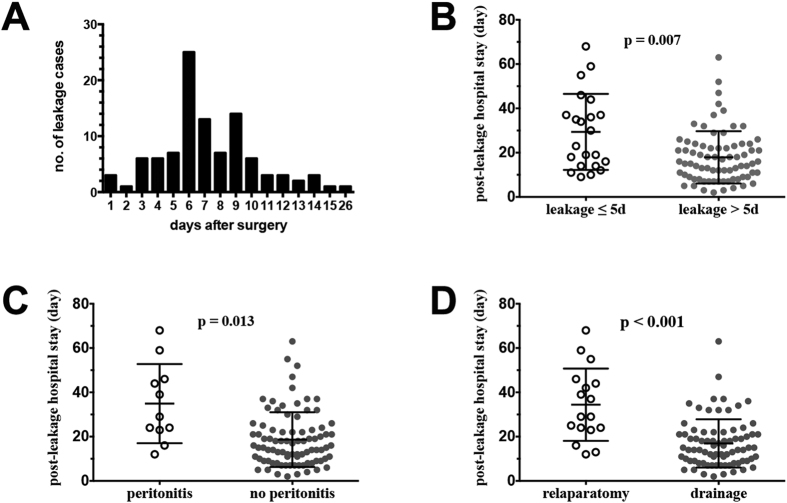
(A) Time distribution of 101 anastomotic leakages. (B–D) Difference of post-leakage hospital stay between subgroups according to anastomotic leakage time (B) presence of peritonitis (C) and choices of treatment (D).